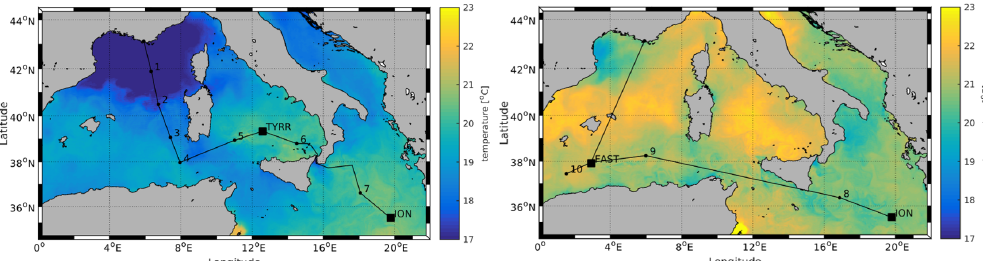
Figure 7. Sea surface temperature during the cruise; (left) outward route (10–28 May) and (right) return route (28 May–10 June). The daily satellite pixel data are used to produce a weighted mean. The weight for each pixel is calculated by normalizing by the square of the inverse distance from the pixel to the daily mean ship position. The ship track is shown in black, and the short (long) station positions are indicated with black dots (squares). (Courtesy of Louise Rousselet.)